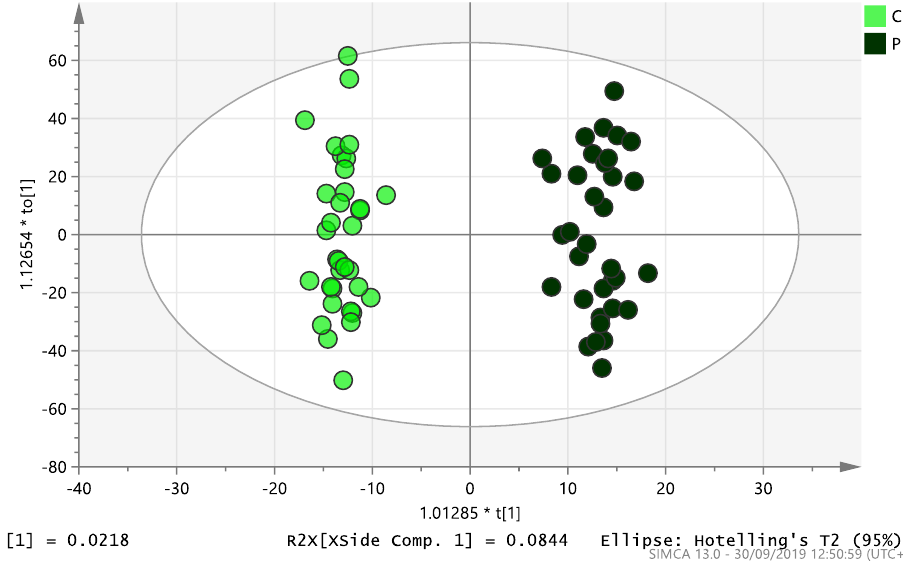
Figure 4. Multivariate analysis based on all detected ions from plasma samples: OPLS-DA score plot of control (C, n = 34) and PCOS (P, n = 34). R2X(cum) = 0.196 and Q2(cum) = 0.312.